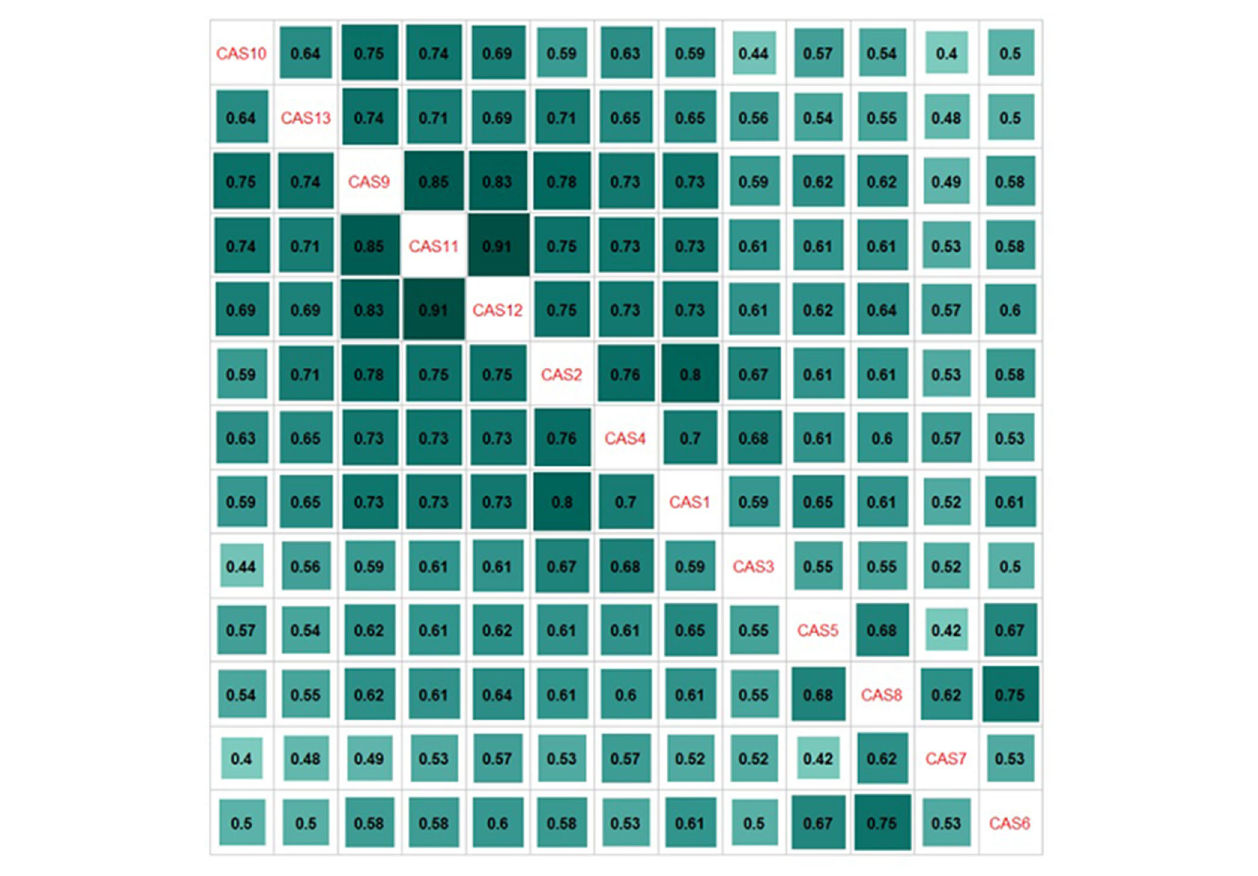
FIGURE 2 | The polychoric correlation matrix for the CAS items ( N =